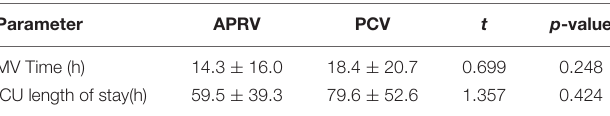
Values are means ±